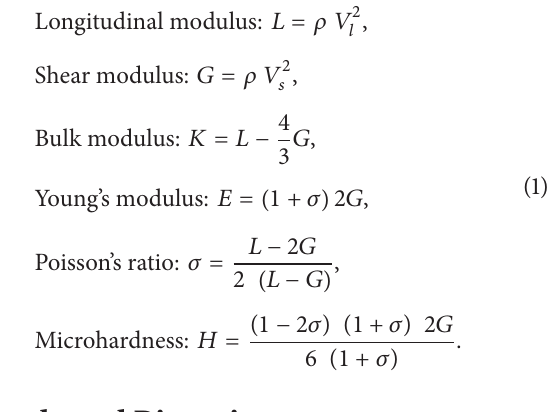
Table 1: The room temperature physical and elastic properties of binary borate lead (PB) and bismuth (BB) glasses’ density ( 𝜌 ), molar volume ( 𝑉 𝑚 ), atomic volume ( 𝑉 𝑎 ), ultrasonic longitudinal ( 𝑉 𝑙 ) and transverse ( 𝑉 𝑠 ) velocities, longitudinal modulus ( 𝐿 ), shear modulus ( 𝐺 ), bulk modulus ( 𝐾 ), Young’s modulus ( 𝐸 ), Poisson’s ratio ( 𝜎 ), and microhardness ( 𝐻 ). PB = (PbO)